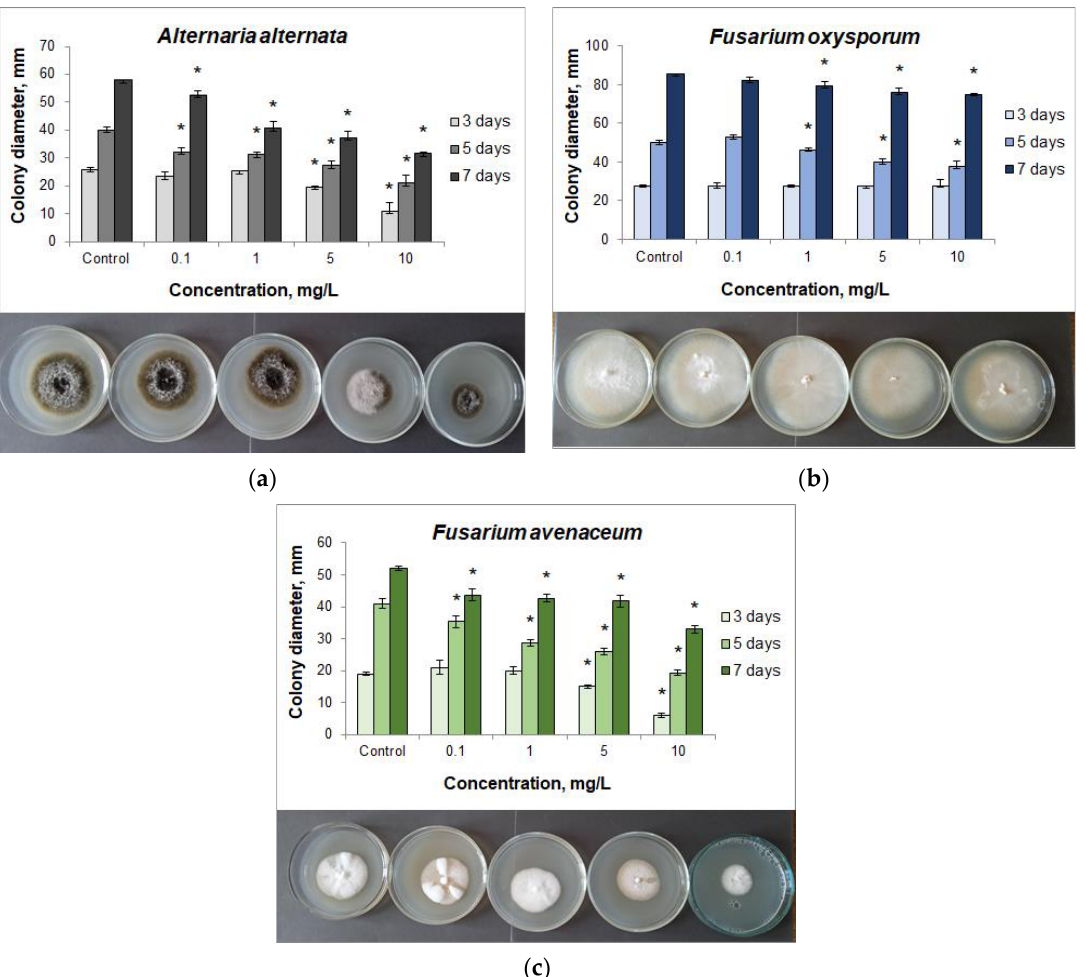
Figure 4. Influence of CuO NPs on the growth of phytopathogenic fungal colonies Alternaria alternata ( a ), Fusarium oxysporum ( b ), and Fusariun avenaceum ( c ) on days 3, 5, and 7 of growth under the influence of NPs (* is significant deviation from control). The difference in the size of a fungal colony was shown on Czapek’s medium containing various concentrations of nanoparticles on the 7th day of growth.